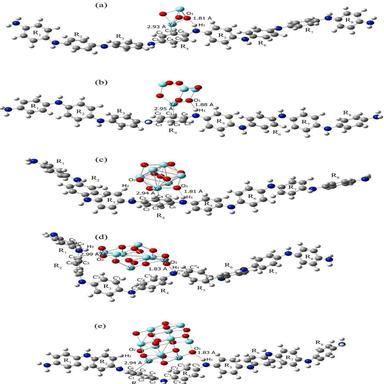
Optimized structures of (a) PANI-LB/Y2O3 , (b) PANI-LB/(Y2O3 )2 , (c) PANI-LB/Y2O3 , (d) PANI-LB/(Y2O3 )4 , and (e) PANI-LB/(Y2O3 )5 nanocomposites.